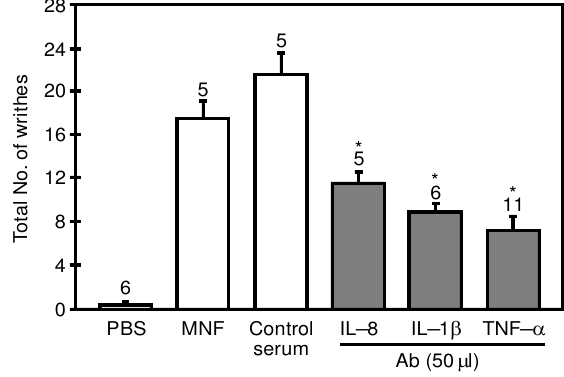
FIG. 4. Effect of antisera against TNF- a , IL-1 b or IL-8 on the nociception induced by MNF. The MNF samples were incubated with 50 m l of the anti-cytokine sera or with control serum for 10 min and then injected i.p. The values are reported as means SEM of the total number of writhes occurring between 14 and 34 min after challenge with MNF alone or in combination with the sera. PBS, number of writhes induced by PBS. The number at the top of each bar represents the number of mice in that group. , Statistically signi® cant differences (P , 0 · 05) from the positive control group (MNF) determined by ANOVA and Bonferroni’s